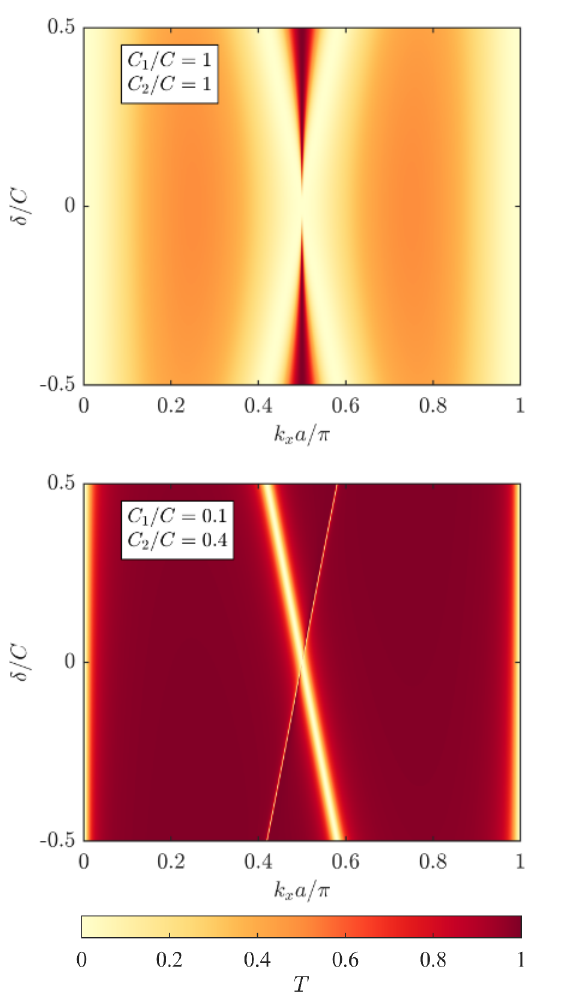
Figure 3. The transmittance T of the coupled-array system shown in Fig. 1 as a function of the Bloch wavenumber k x and the asymmetry parameter δ = − δ − 1 = δ 1 . The coupling coe ffi - cients C 1 and C 2 are indicated in the insets.